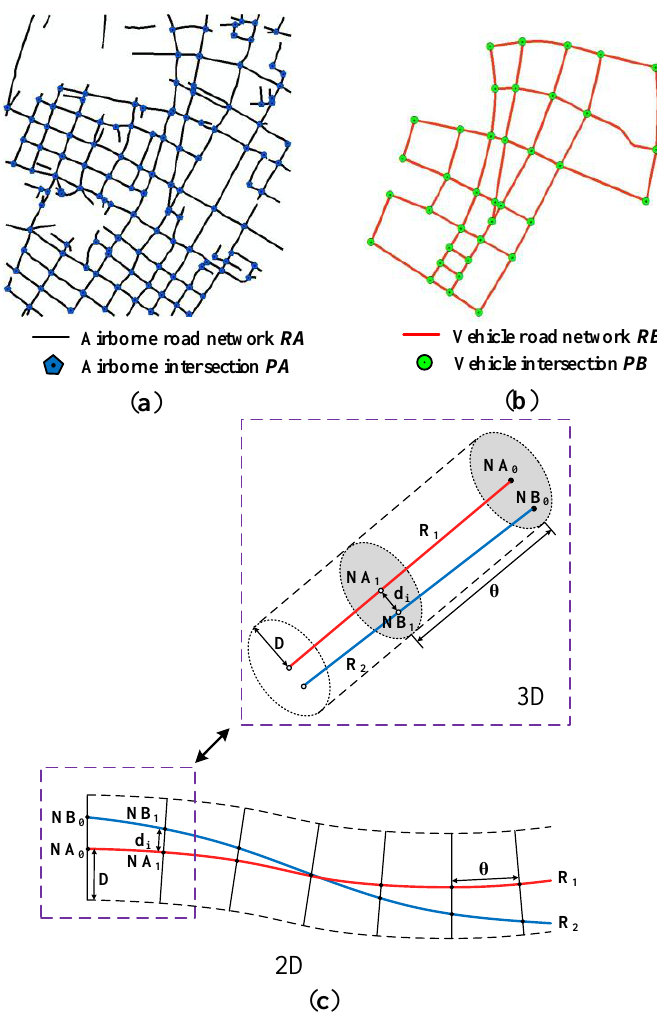
Figure 3. Coarse registration of 3D road networks. ( a ) Airborne road networks and intersections; ( b ) Vehicle road networks and intersections; ( c ) Matching rate of two single road segments from 3D road